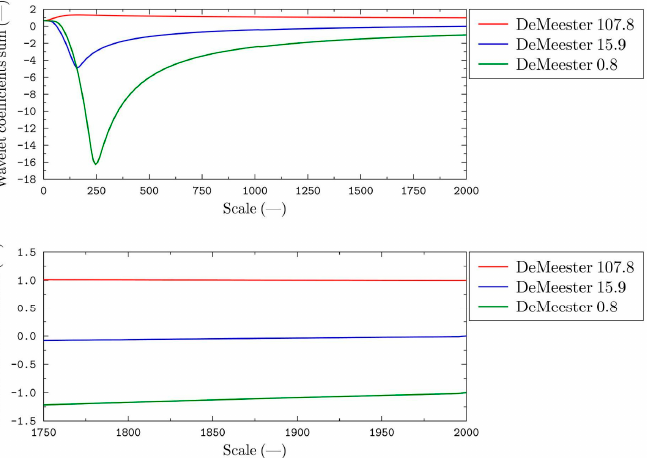
Figure 9. Curves representing rescaled sums of wavelet coefficients. Different colours indicate marginal cases of calculated DeMeester score: blue line—base line (DeMeester 15.9); red line—a patient diagnosed with reflux (DeMeester 107.8); green line—healthy patient (DeMeester 0.8).